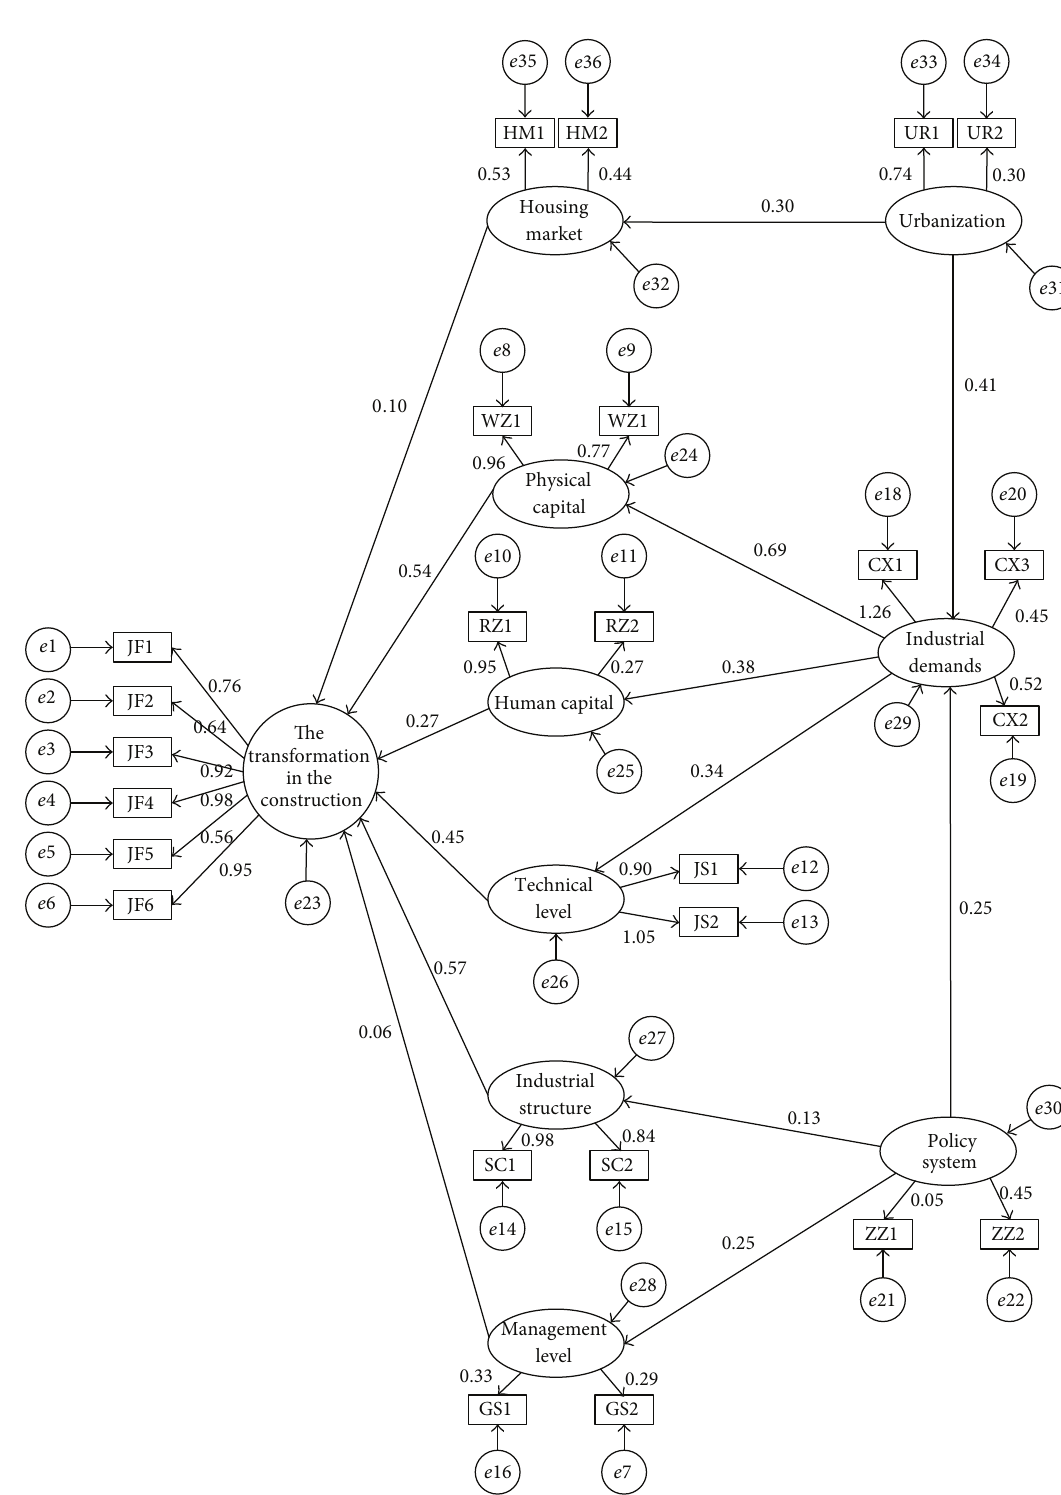
JF6JF5JF4JF3JF2JF1 Figure 2: Structural equation model estimation